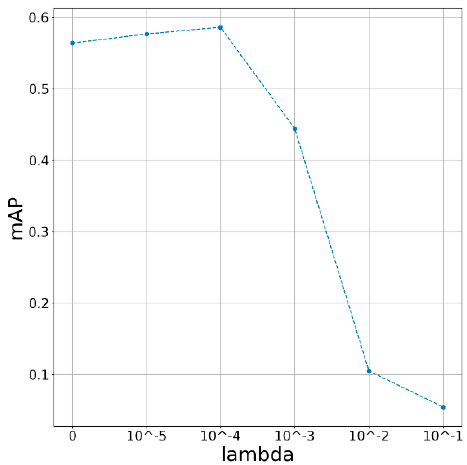
Figure 11. Models with different λ .